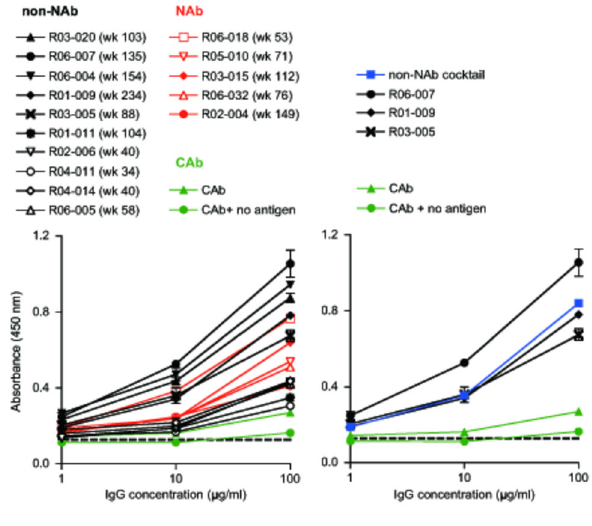
Figure 1. Binding properties of IgGs to SIV virions. Polyclonal IgGs purified from macaque plasma were subjected to whole virus ELISA using purified SIV as the antigen. Results on ten IgG lots derived from